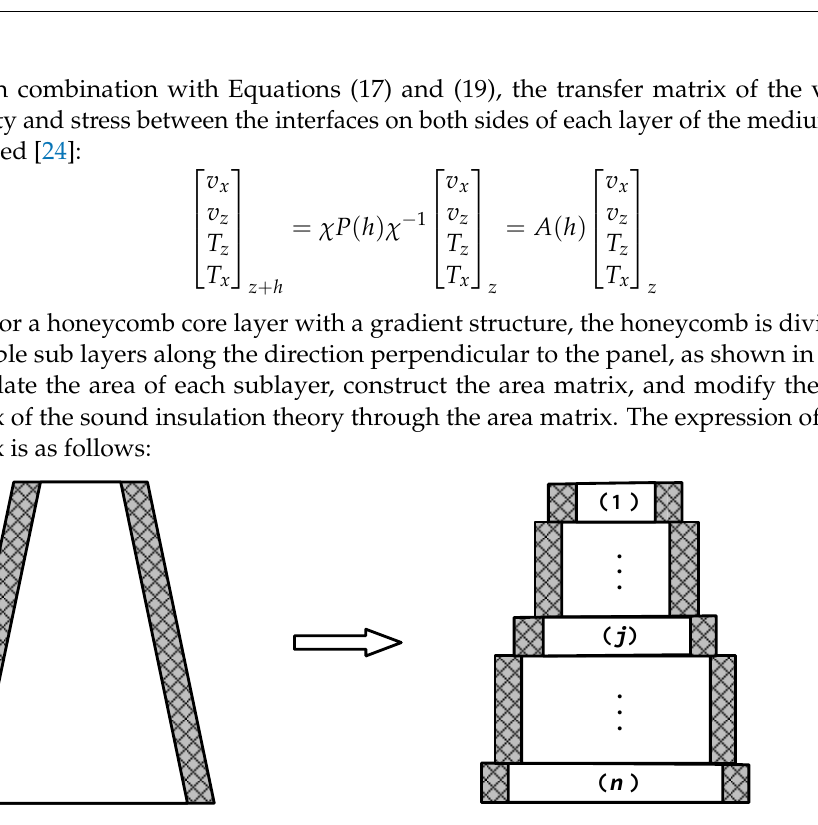
Figure 3. Equivalent delamination of a gradient honeycomb.